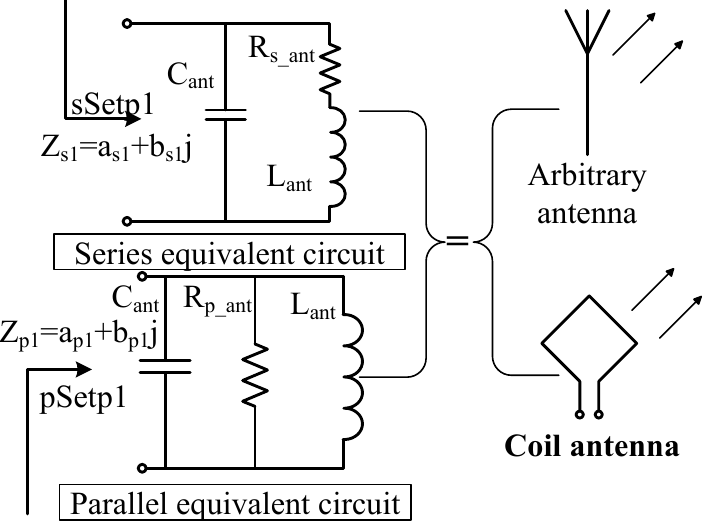
Figure 2. Equivalent circuit models for general antennas.